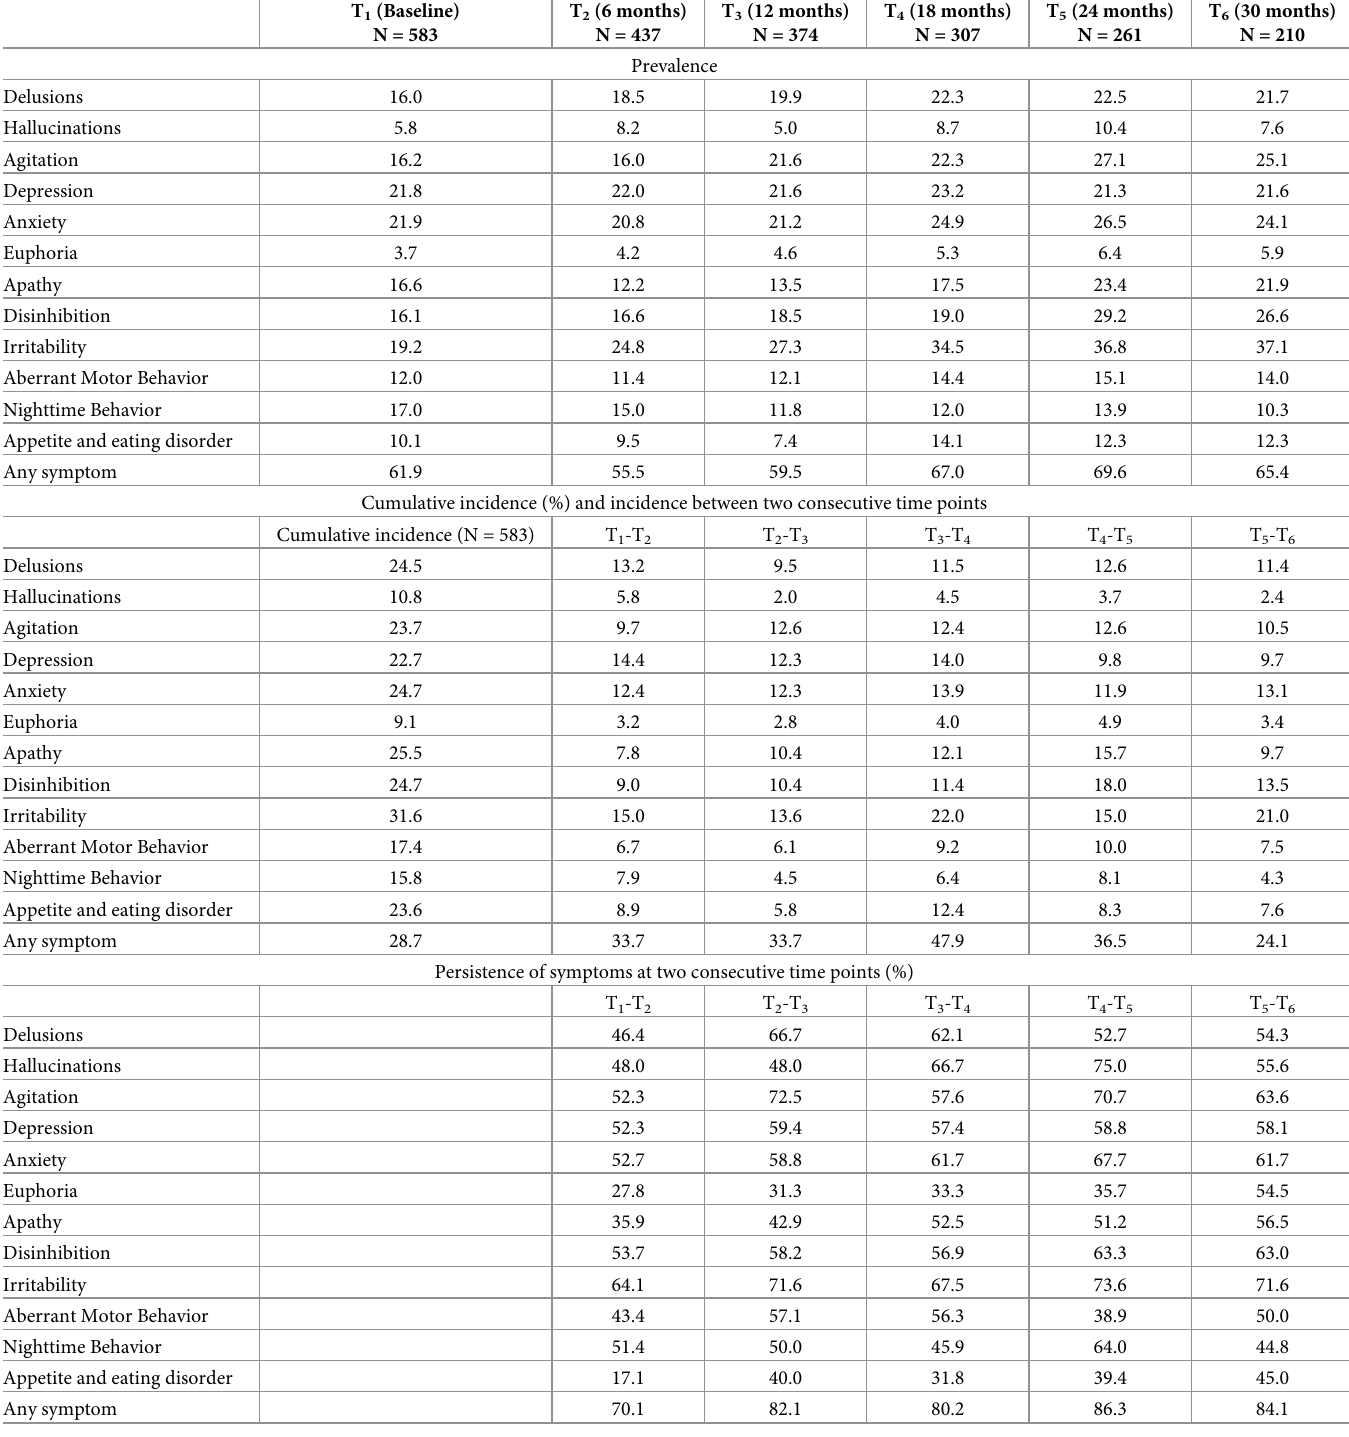
Table 3. Prevalence, incidence and persistence of significant neuropsychiatric symptoms (NPS) at each assessment